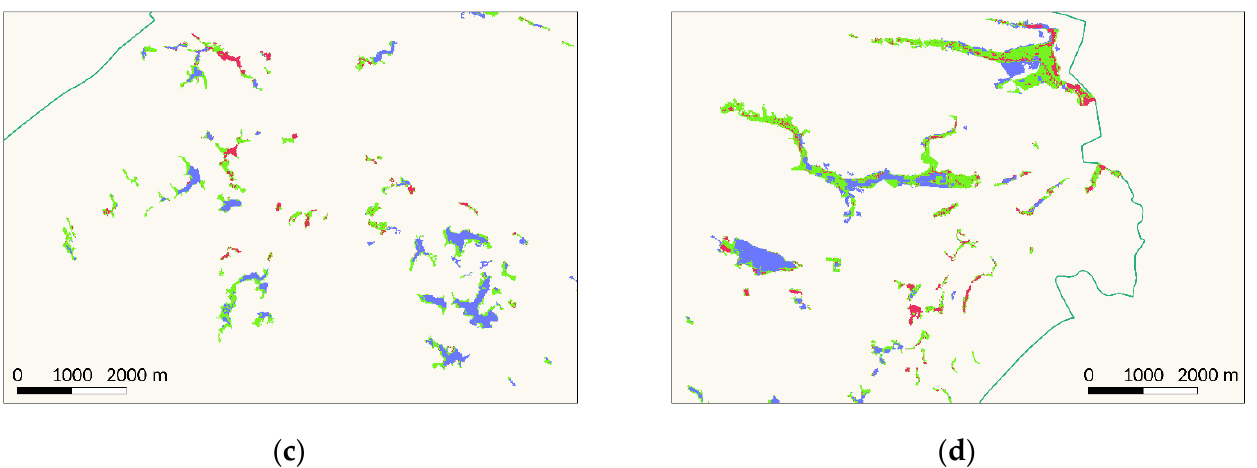
Figure 5. Lotus distribution mapping derived from the sGTB model and Sentinel-2 imagery with the four enlarged areas ( a – d ).